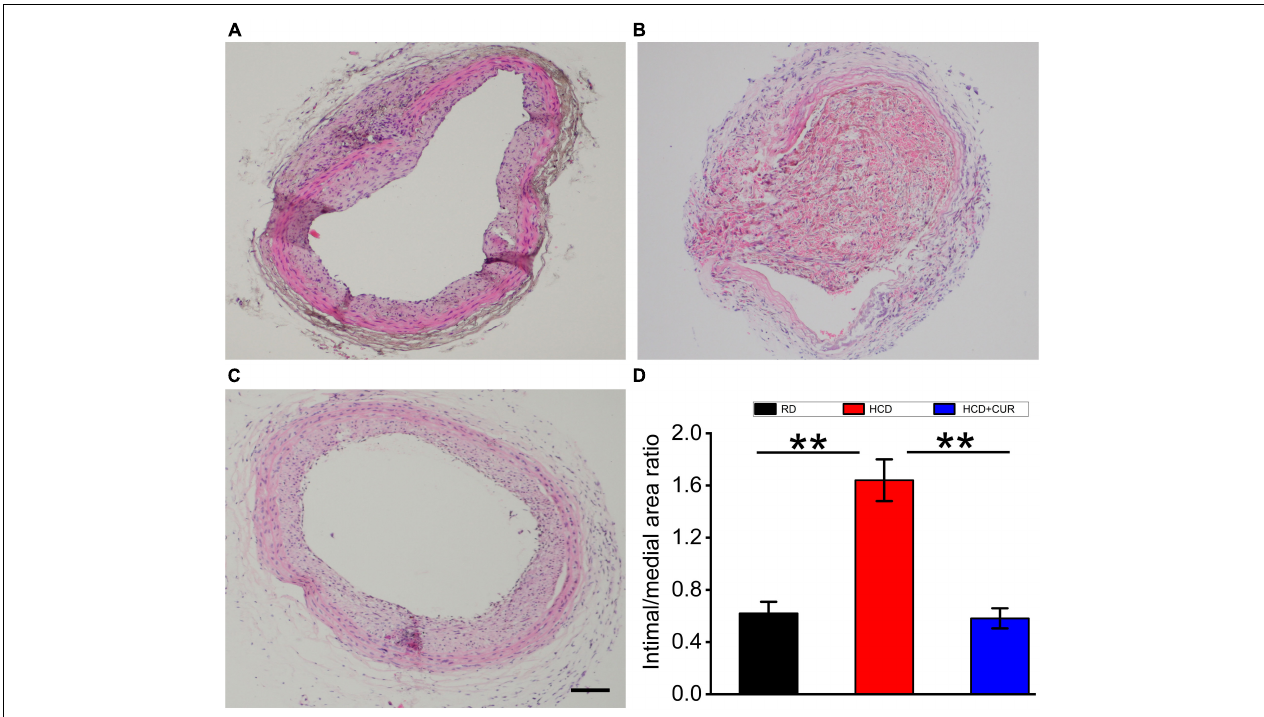
FIGURE 3 | Changes in pathomorphology of common carotid artery in rats. H&E staining of representative cross-sections at the center of the injured region of carotid arteries, (A) RD group; (B) HCD group; (C) HCD + CUR group; (D) image analysis of carotid stenosis ratios (%) expressed as intima/media area × 100% (I/M ratio). RD, control group; HCD, high cholesterol diet group; HCD + CUR, high cholesterol diet receiving a daily dose of 200 mg/kg body weight curcumin by gavage for 4 weeks. Carotid injury was induced by an air-drying endothelial denudation method at the end of the second week. Data are representative of two independent experiments and are expressed as mean ± SE, n = 6 for each group. ** P < 0.01. Scale bar in (A–C) = 100 µ